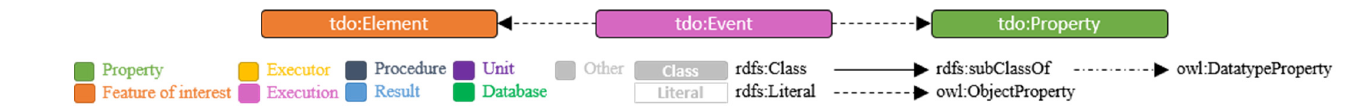
Figure 11. Procedure execution pattern of PEP, generalizing SEAS. Next to this, SEAS directly links the result class (seas:Evaluation) to the property class. This pattern resembles opm:PropertyState and PowerOnt. PowerOnt [93] is a very lightweight ontology that uses a specific syntax to model the energy consumption of electrical devices (Figure 12). The ontology serves as an extension of multiple other ontologies in the smart building domain, such as DogOnt [100] and IoT-O [91]. Figure 12. Linking the property (PowerConsumption) and result (PowerConsumptionValue) class using PowerOnt. Alirezaie et al. [95] combined eight ODPs to develop their SmartEnv Ontology. The ontology’s goal is to represent smart, sensorized environments. It contains building blocks for objects, events, situations, sensing, networks, place, geometry, and time. Multiple ontologies, such as SSN, SOSA, and DUL, were integrated. By integrating ODPs, Alirezaie et al. tried to avoid the design issues that appear when integrating complex ontologies. Although succeeding in this goal, the object properties between the ODPs contain too few object restrictions to answer complex competency questions [92]. A SmartObject is introduced, representing instances that are both physical objects and features of interest. Actuation is not included in SmartEnv. Another attempt to integrate multiple ODPs is IoT-O [91]. It combines a sensing ontology (SSN), an actuation ontology (SAN), a lifecycle ontology (Lifecycle (https://vocab.org/lifecycle/schema, accessed on 22-09-2022)), a service ontology (MSM